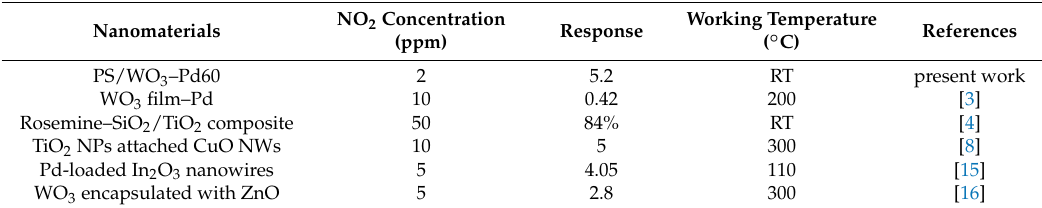
Table 1. Comparisons of NO 2 concentration, response, and working temperature of the PS/WO 3 –Pd60 sensor with those of other nanomaterial